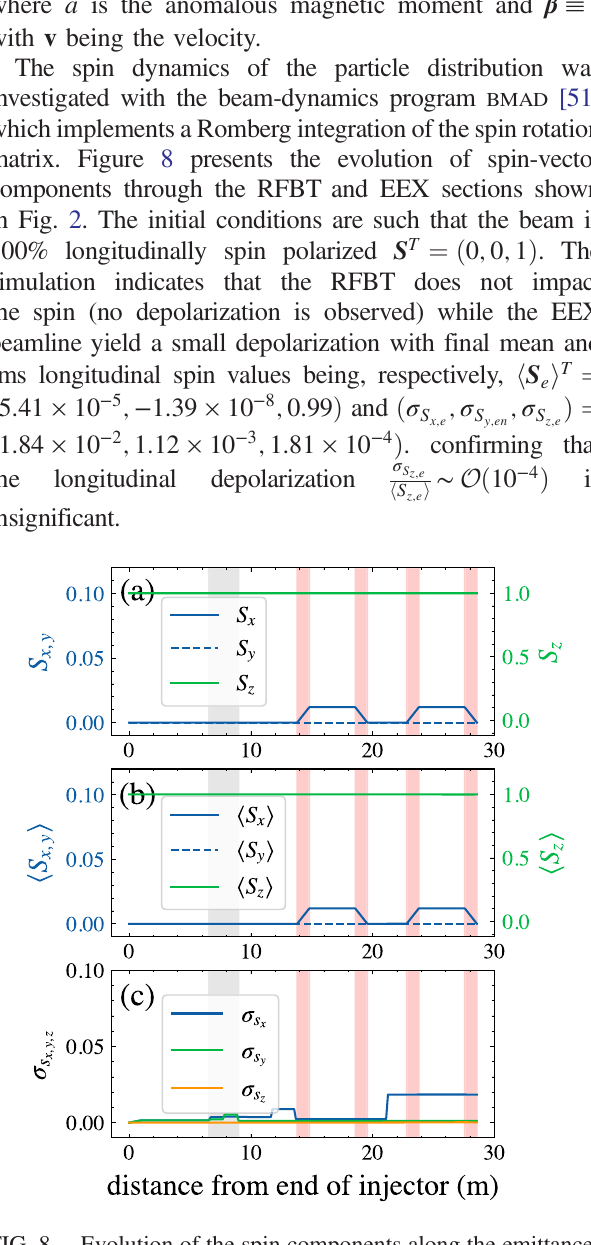
FIG. 8. Evolution of the spin components along the emittance- manipulation beamline. Spin components associated with the reference particle S T ¼ ð S x ; S y ; S z Þ (a), statistical average h S i (b) and rms value h S 2 i 1 = 2 (c) computed over the macroparticle distribution. The vertical shaded bands indicate the locations for the RFBT ’ s skew-quadrupole magnets (gray band at distances < 10 m are for SQ1-3) and dipole magnets (red bands from ∼ 14 m to the end of the beamline are for B1-4) are associated with the EEX beamline; see Fig.